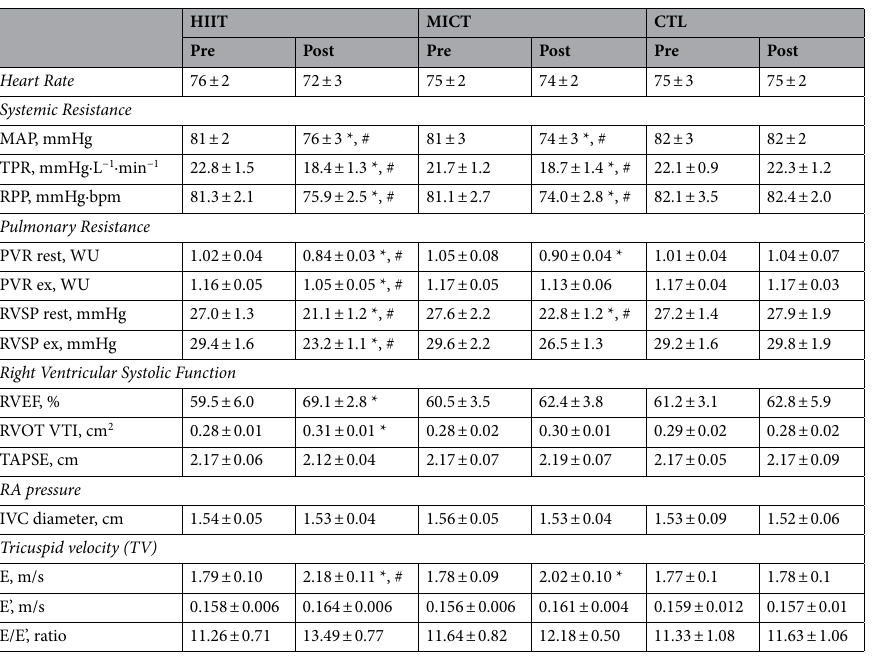
Table 2. The effects of interval and continuous exercise regimens on echocardiographic parameters in hypoxia at rest and during HE . Values were mean ± SEM. Resting images were acquired after the subject was placed in the semi-supine position for 10 min under hypoxia. HIIT, high-intensity interval training group; MICT, moderate-intensity continuous training group; CTL, control group; Pre, pre-intervention; Post, post- intervention; MAP, mean arterial pressure; TPR, total peripheral pressure; RPP, rate pressure product; PVR, pulmonary vascular resistance; RVSP, right ventricular systolic pressure; RVEF, right ventricular ejection fraction; RVOT VTI, right ventricular outflow tract velocity time integral; TAPSE, tricuspid annular plane systolic excursion; IVC, inferior vena cava; E, the peak velocity of early tricuspid blood flow; E’, the peak velocity of early tricuspid annular tissue; * P < 0.05, Pre vs . Post; ** P < 0.05, HIIT vs. MICT; # p < 0.05, HIIT or MICT vs